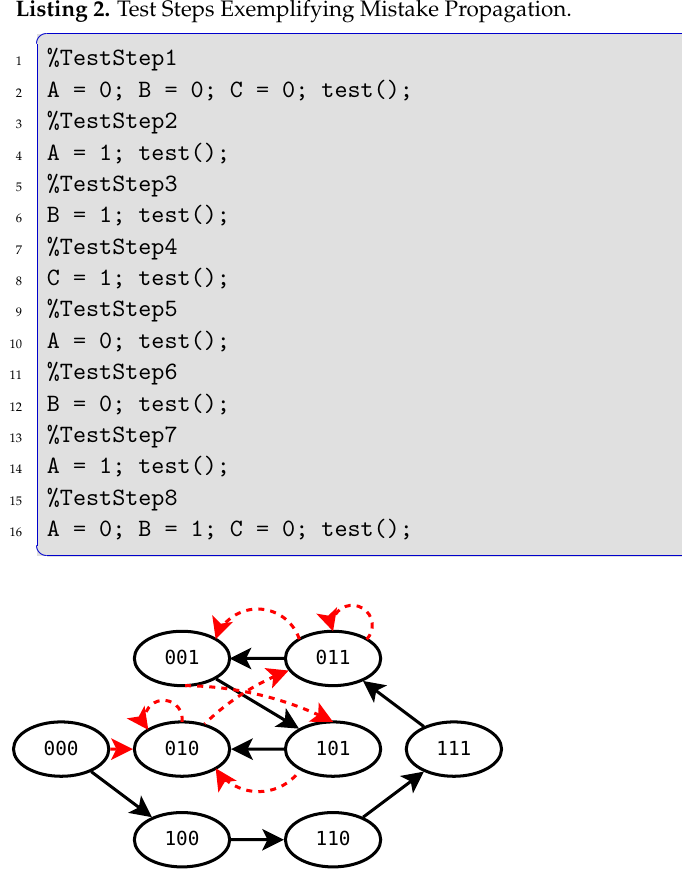
Figure 1. Teststepping through the State